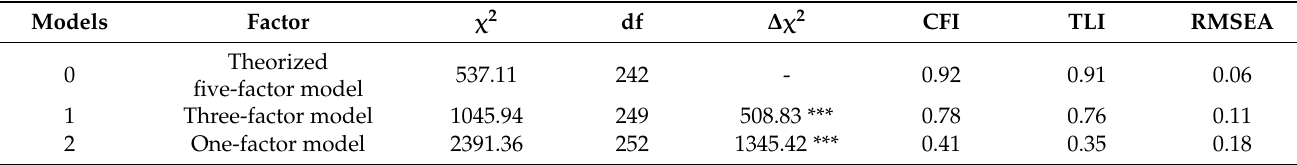
Table 2. Comparison of measurement